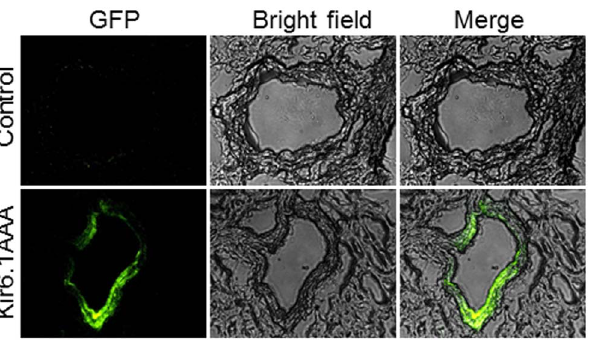
Figure 4. Coronary artery transfection with Kir6.1AAA. Fluorescence microscopy was performed on heart sections containing coronary arteries. Sections were from Control (row 1) and Ad-Kir6.1AAA-GFP transfected (row 2) hearts. Column 1 shows GFP images, column 2 shows the respective bright field images of the vessels, and column 3 shows the merged images. Magnification is 400X. Green fluorescence representing the expression of Kir6.1AAA is clearly evident in the coronary vessel section, indicating successful transfection with Kir6.1AAA.